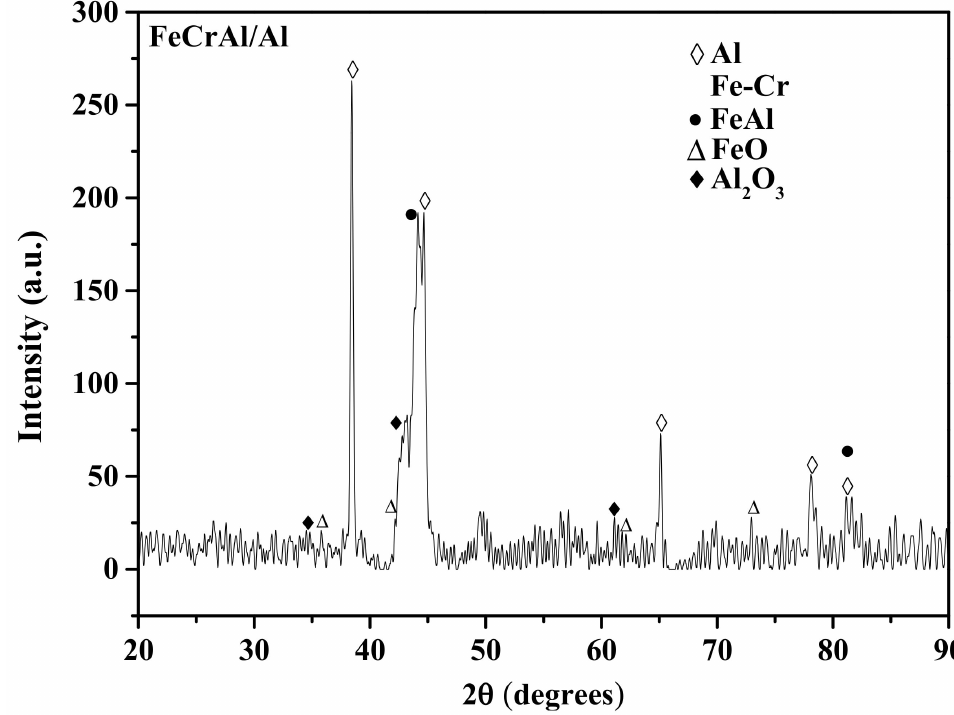
Figure 5. XRD patterns of the as-sprayed